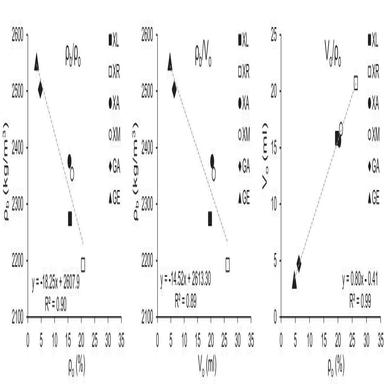
Linear correlations for porosity and density parameters.